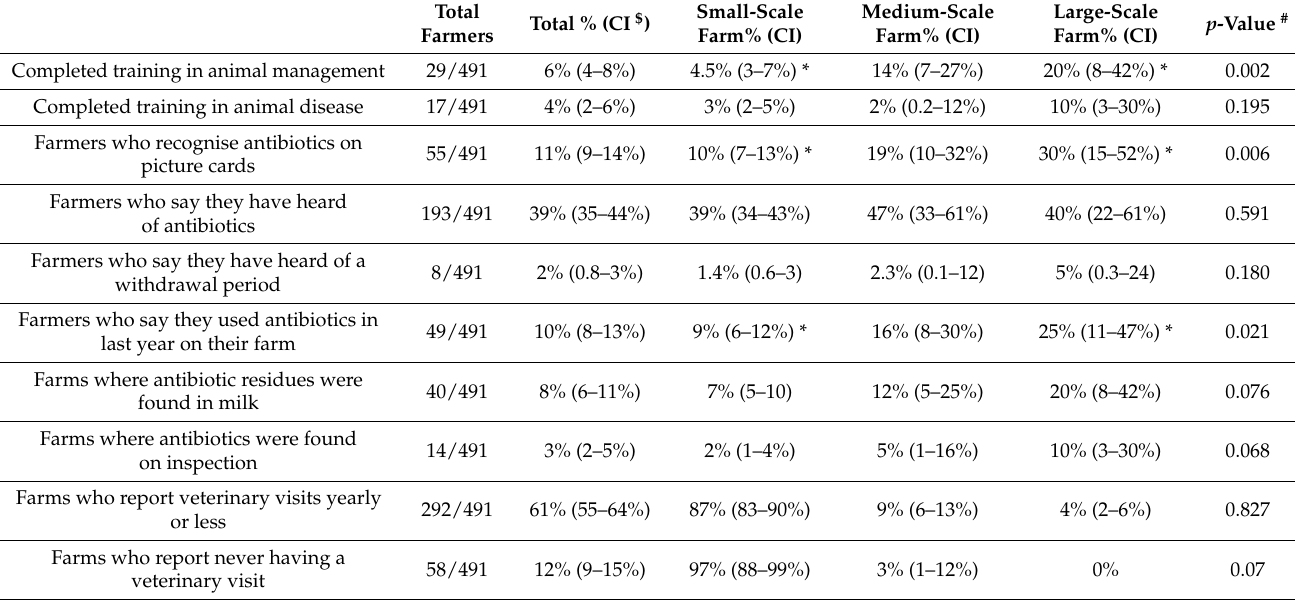
Table 1. Dairy farmer training and knowledge about antibiotics in Assam and Haryana, India. Total